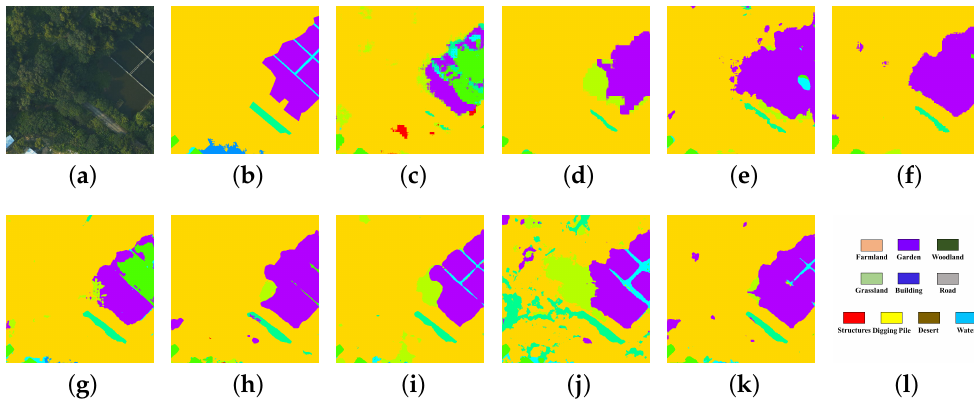
Figure 17. Segmentation results on the Evlab dataset with different models. ( a ) Image; ( b ) Ground Truth; ( c ) FCN-8s; ( d ) PSPNet; ( e ) Deeplab V3+; ( f ) HRNet V2; ( g ) SDFCN V1; ( h ) SDFCNv2;